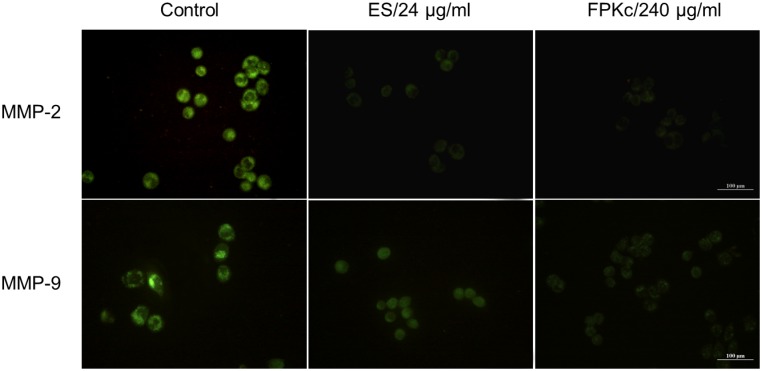
Measurement of MMP-2 and MMP-9 expression level in SW-480 cells after FPKc treatment.SW-480 cells were fixed and processed for immunofluorescence, MMP-9 and MMP-2 were visualized using FITC-label second antibody (green). Scale bars, 100 µm.